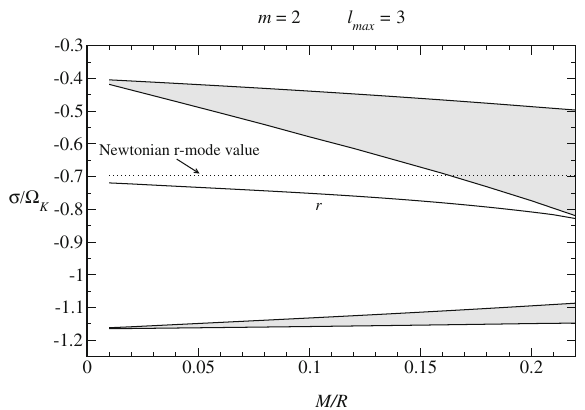
Fig.18 Relativistic r -modefrequenciesforarangeofthecompactnessratio M / R .Thecouplingofpolarand axial terms, even in the order O (Ω) slow rotation approximation has a dramatic impact on the continuous frequency bands (shaded areas), allowing the r -mode to exist even in highly compact stars. The Newtonian value of the r -mode frequency is plotted as a dashed-dotted line. (Image reproduced with permission from Ruoff et al. 2003, copyright by